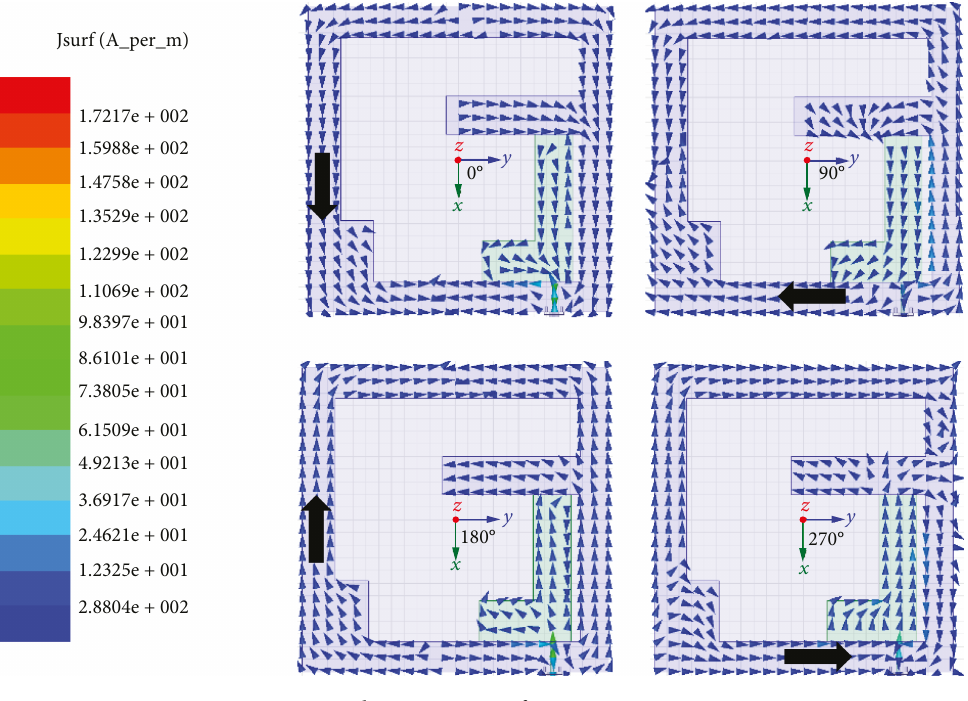
Figure 4: Distribution currents of Antenna 4 at 900 MHz.